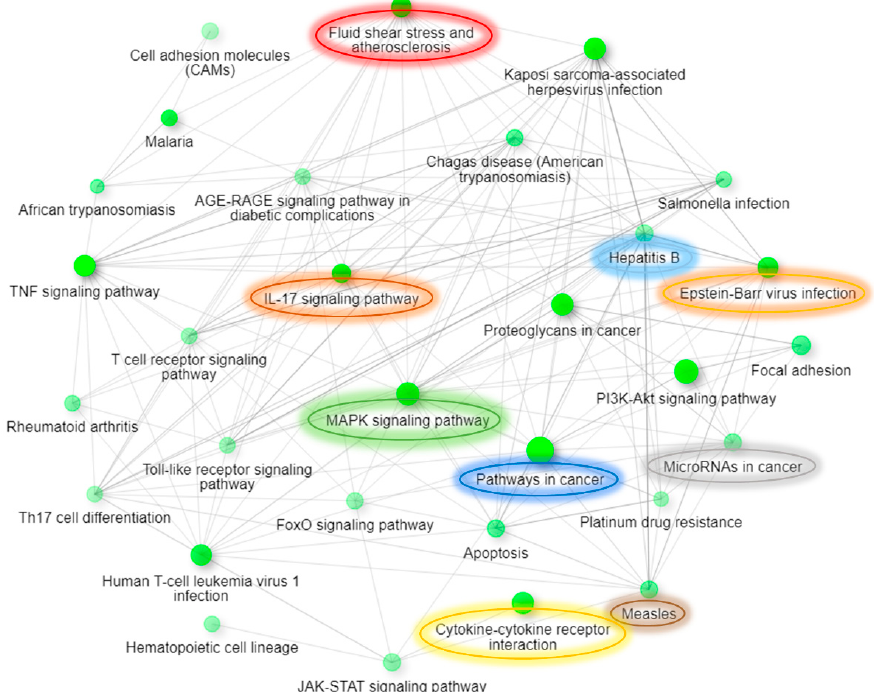
Figure 9. Enriched molecular pathways after treatment of hTCEpi cells with AC EFs for 24 h. The relationships between pathways are depicted and highlighted as an interactive graphical network using ShinyGO. Pathways enriched following analysis of the antibody array data are shown. Two pathways (nodes) are connected after sharing 20% or more genes. Enriched pathways that were similar after analysis of both gene and protein array data are marked and highlighted. Node colors illustrate enrichment, whereby darker nodes represent significantly enriched gene sets, while bigger nodes represent larger gene sets. Thicker edges represent more overlapped genes. Analysis was performed using ShinyGO (v.0.61) (Available online: http://bioinformatics.sdstate.edu/go/ (accessed on 6 January 2021)). Edge cut-off = 0.2 and FDR p -value cut-off = 0.05.